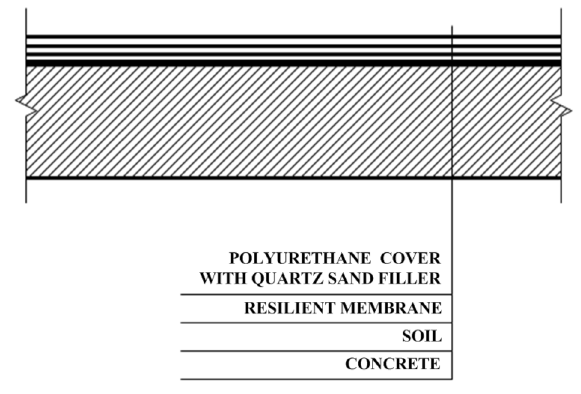
Fig. 16. The layers of car park area coverage in alternative A 1